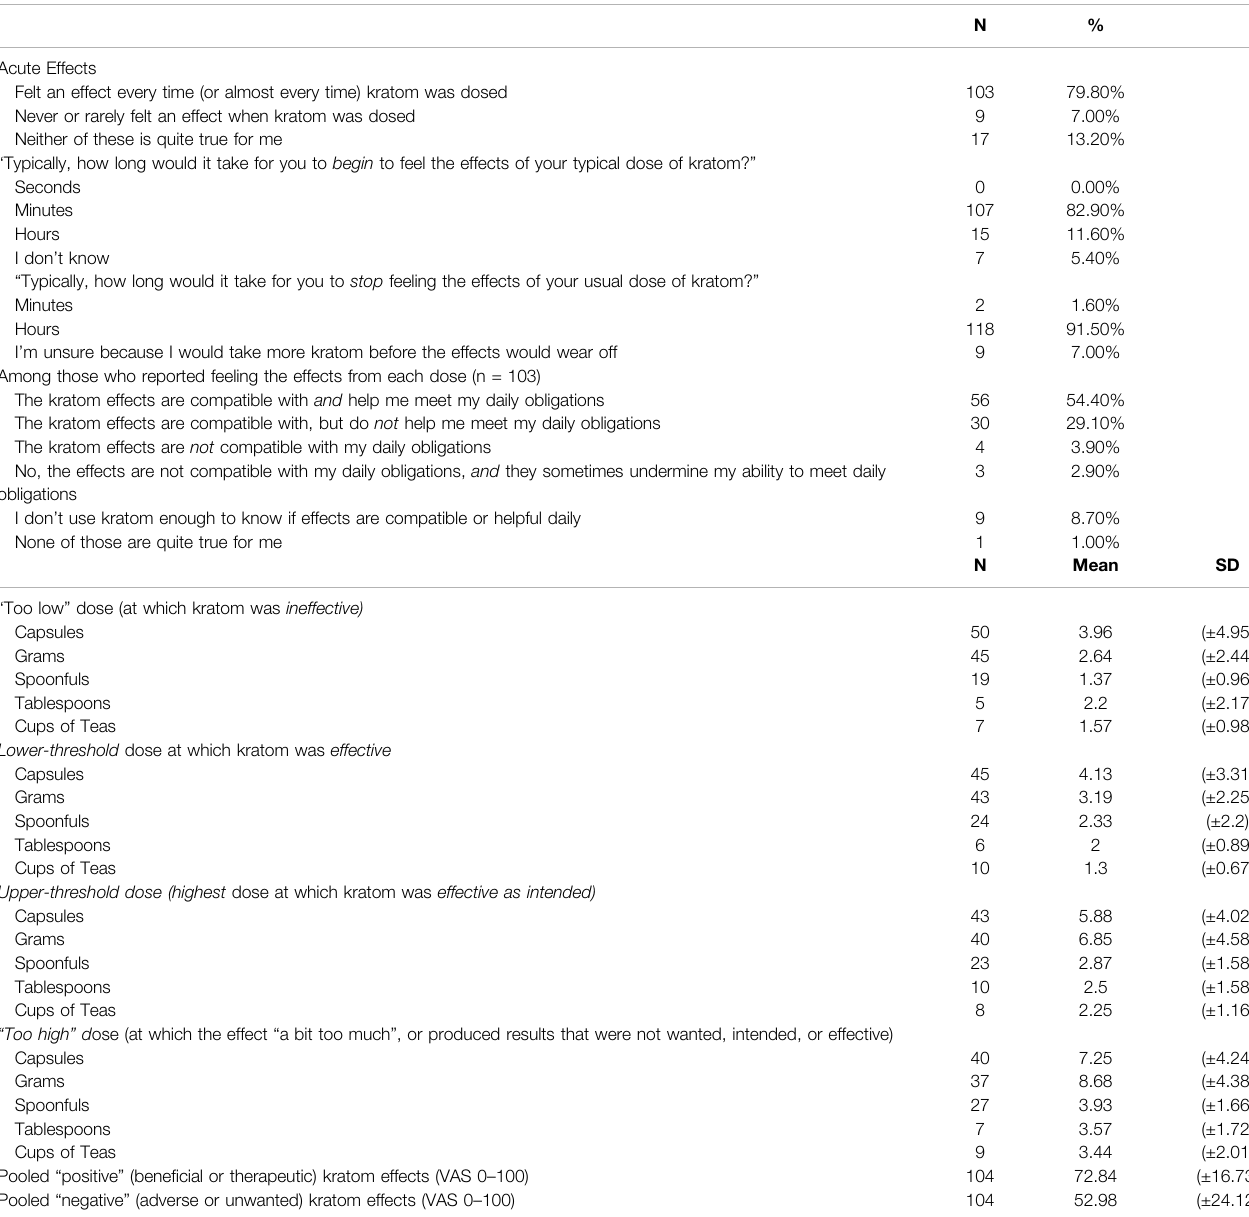
TABLE 2 | Means and proportions for kratom perceived acute effects, compatibility of effects with daily obligations, and effectiveness and ineffectiveness by dose. Total sample (n =